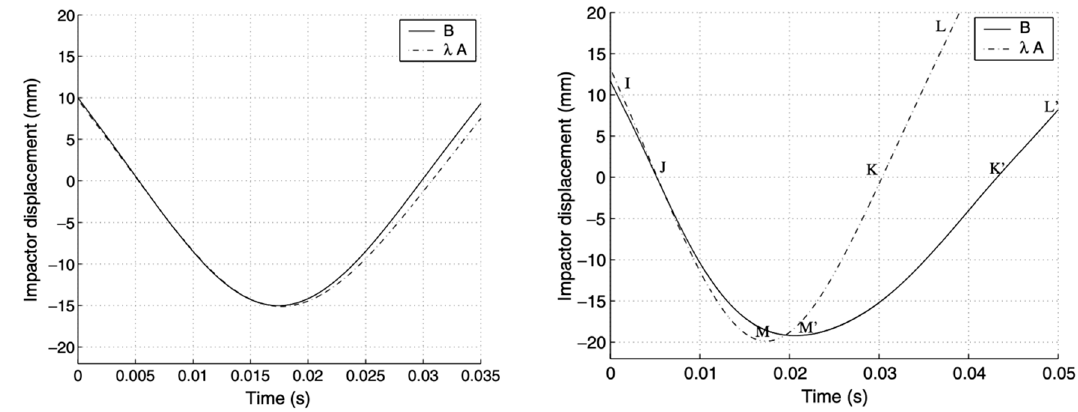
Figure 3. Displacement of the hemispherical dart, at speeds of 1.8 and 2.2 m/s [16].